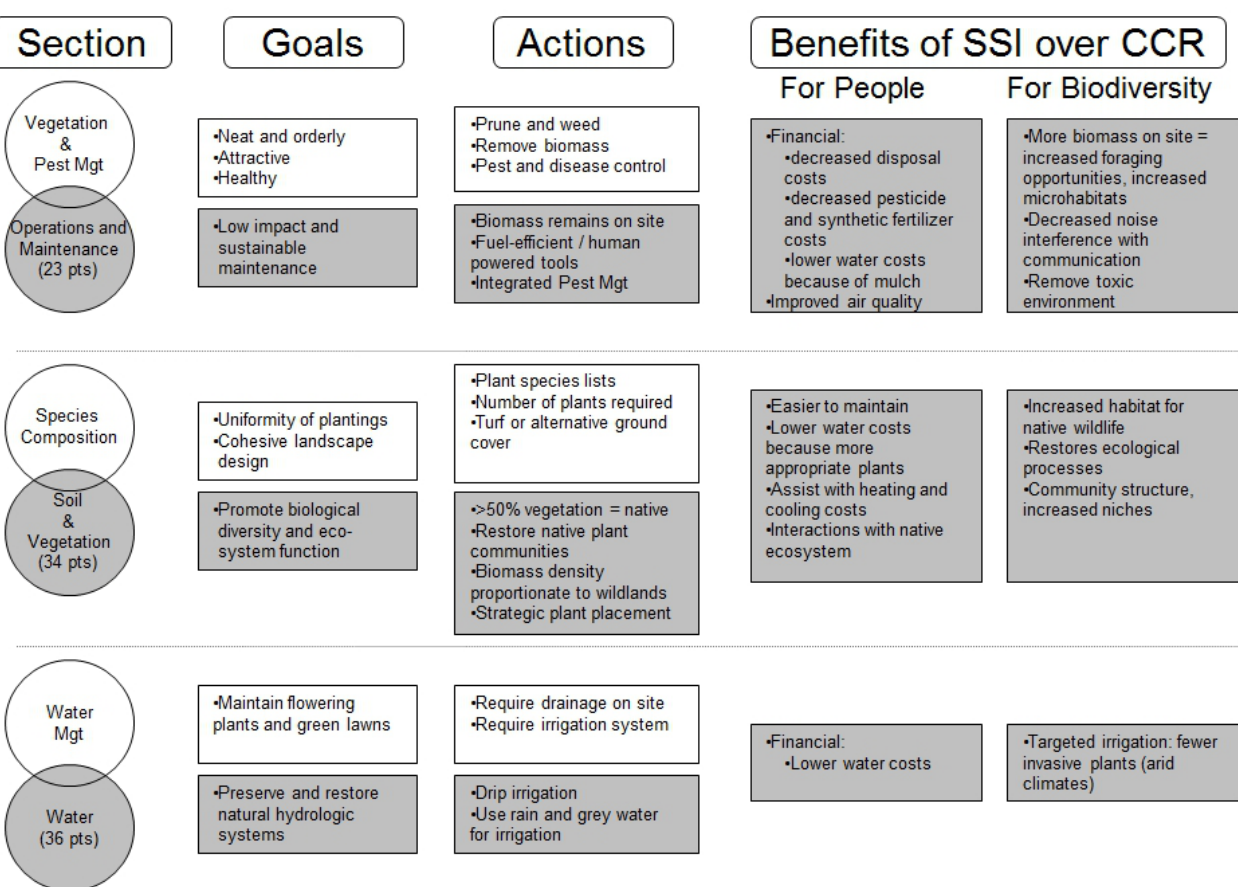
Fig. 4. Common features shared between the covenants, conditions, and restrictions (CCR) and the Sustainable Sites Initiative (SSI). For each section, we identify points available for retrofitting landscapes, goals of each section, examples of landscaping activities, and benefits for people and biodiversity of adapting the SSI features. Shaded circles and rectangles denote SSI features and white circles and rectangles denote CCR